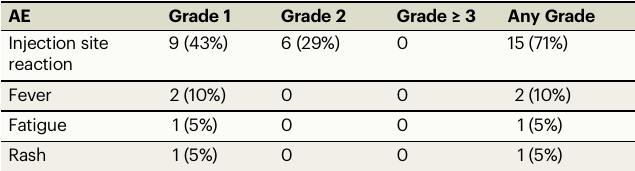
Table 2 | Adverse events (AE) deemed possibly, probably, or certainly related to study drug graded according to Common Terminology Criteria for Adverse Events (CTCAE)